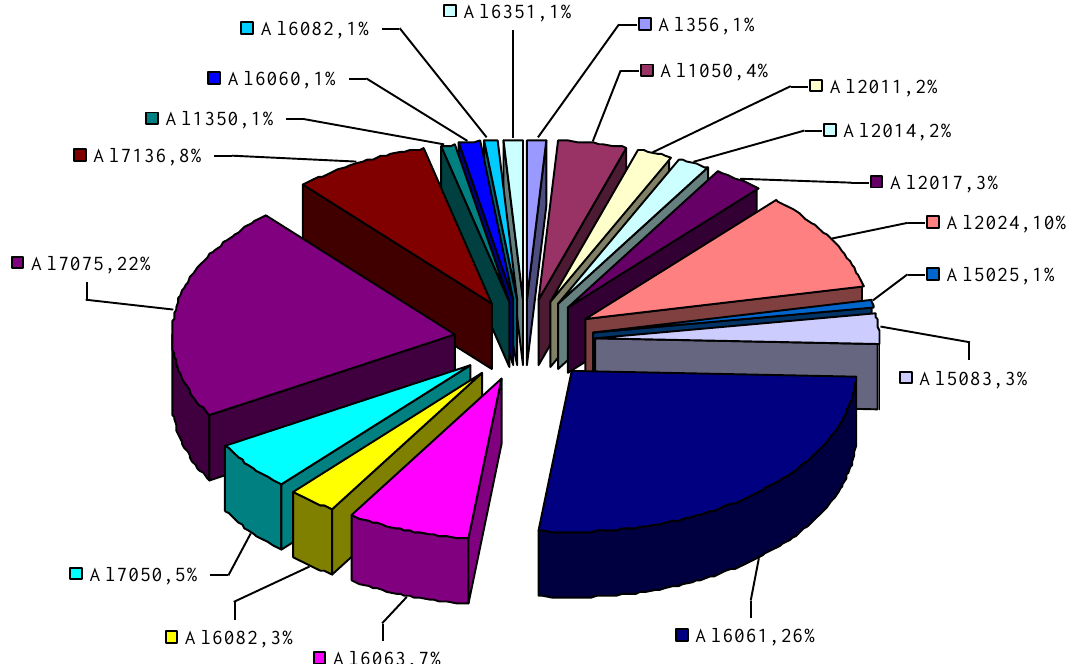
Figure 1. The use of aluminum alloys per year and depending on the number of researches in which they were studied.